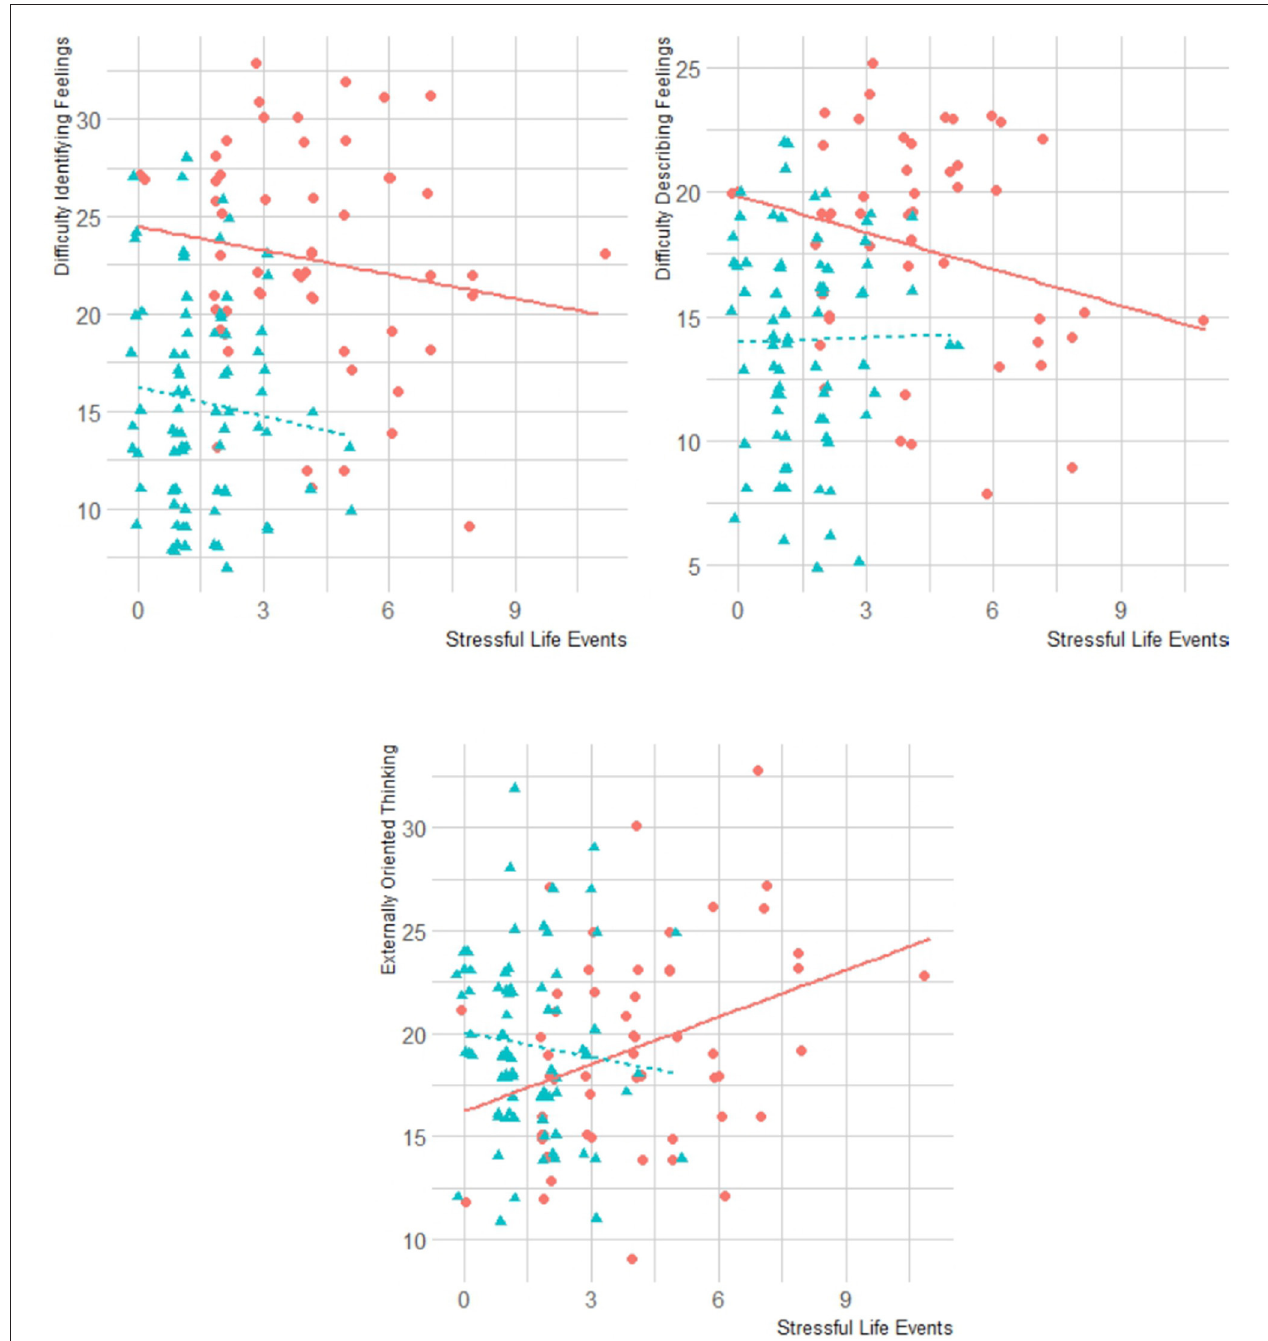
FIGURE 3 | Correlations between alexithymia (total, DIF, DDF, EOT) and SLEs in BPD and HC groups. BPD, borderline personality disorder; HC, healthy controls; TAS, Toronto Alexithymia Scale; DIF, difficulty identifying feelings; DDF, difficulty describing feelings; EOT, externally oriented thinking.